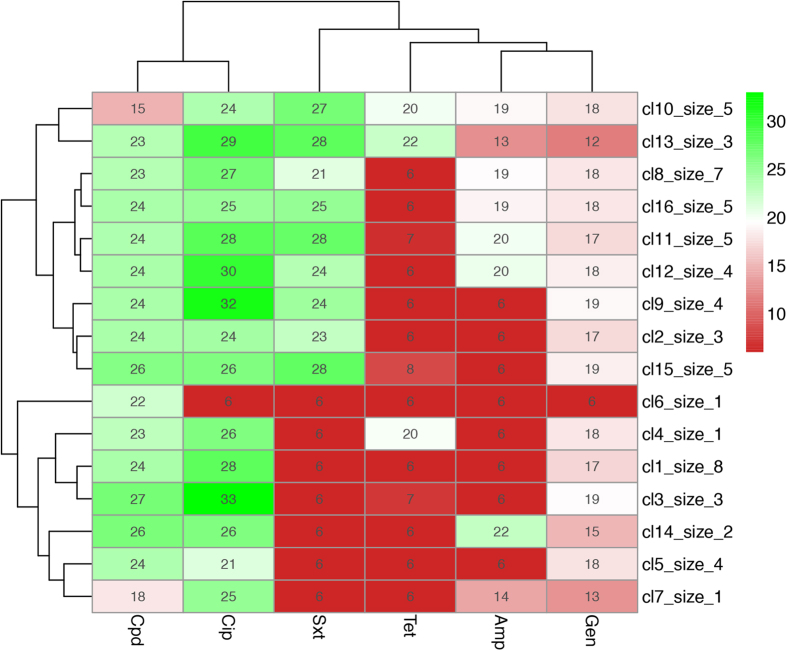
Patterns of antimicrobial resistance phenotypes for E. coli strains isolated in the study.The bottom matrix border shows the different types of antibiotics that were tested in the study, Cpd: cefpodoxime 10 mg; Cip: ciprofloxacin 5 mg; Amp: ampicillin 10 mg; Sxt: sulfamethaxazole/trimethoprim 25 mg; Tet: tetracycline 30 mg and Gen: gentamicin 10 mg. The colour indicates the susceptibility gradient with red indicating resistant and green indicating susceptible. The right margin indicates the antibiogram patterns of phenotypic resistance detected from 1 to 16 (cl1 to cl16) and the numbers of isolates in each resistance pattern from 1 to 10 (size_1 to size_10). The top margin dendrogram indicates the relationship among the antibiotics in terms of their susceptibility testing profiles. The dendrogram on the left margin indicates the clusters of antibiogram patterns in the study.